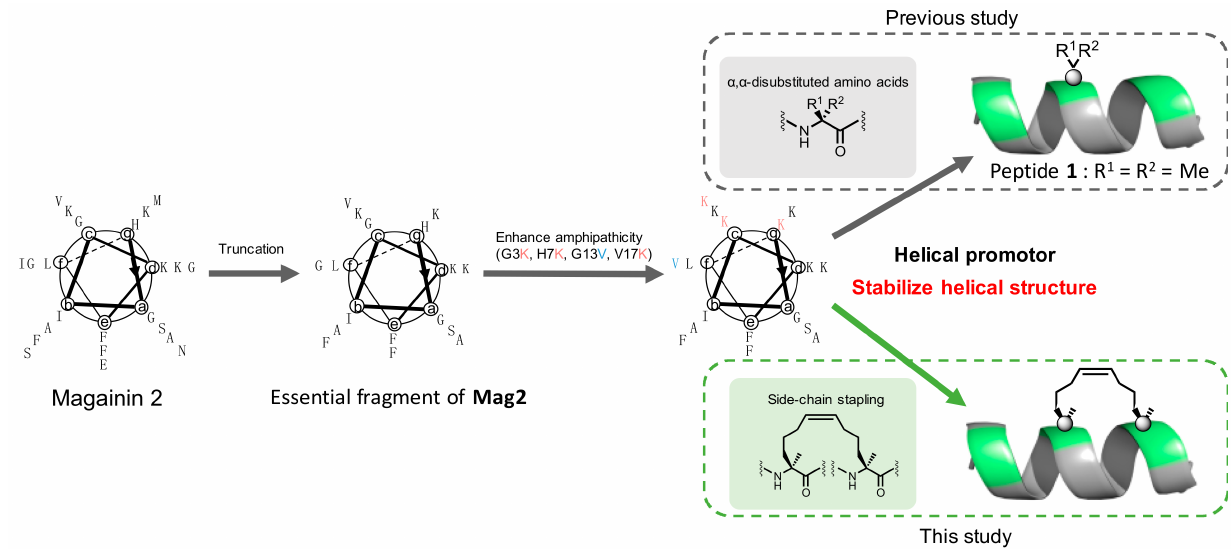
Figure 1. The peptide design based on the essential fragment of magainin 2 ( Mag2